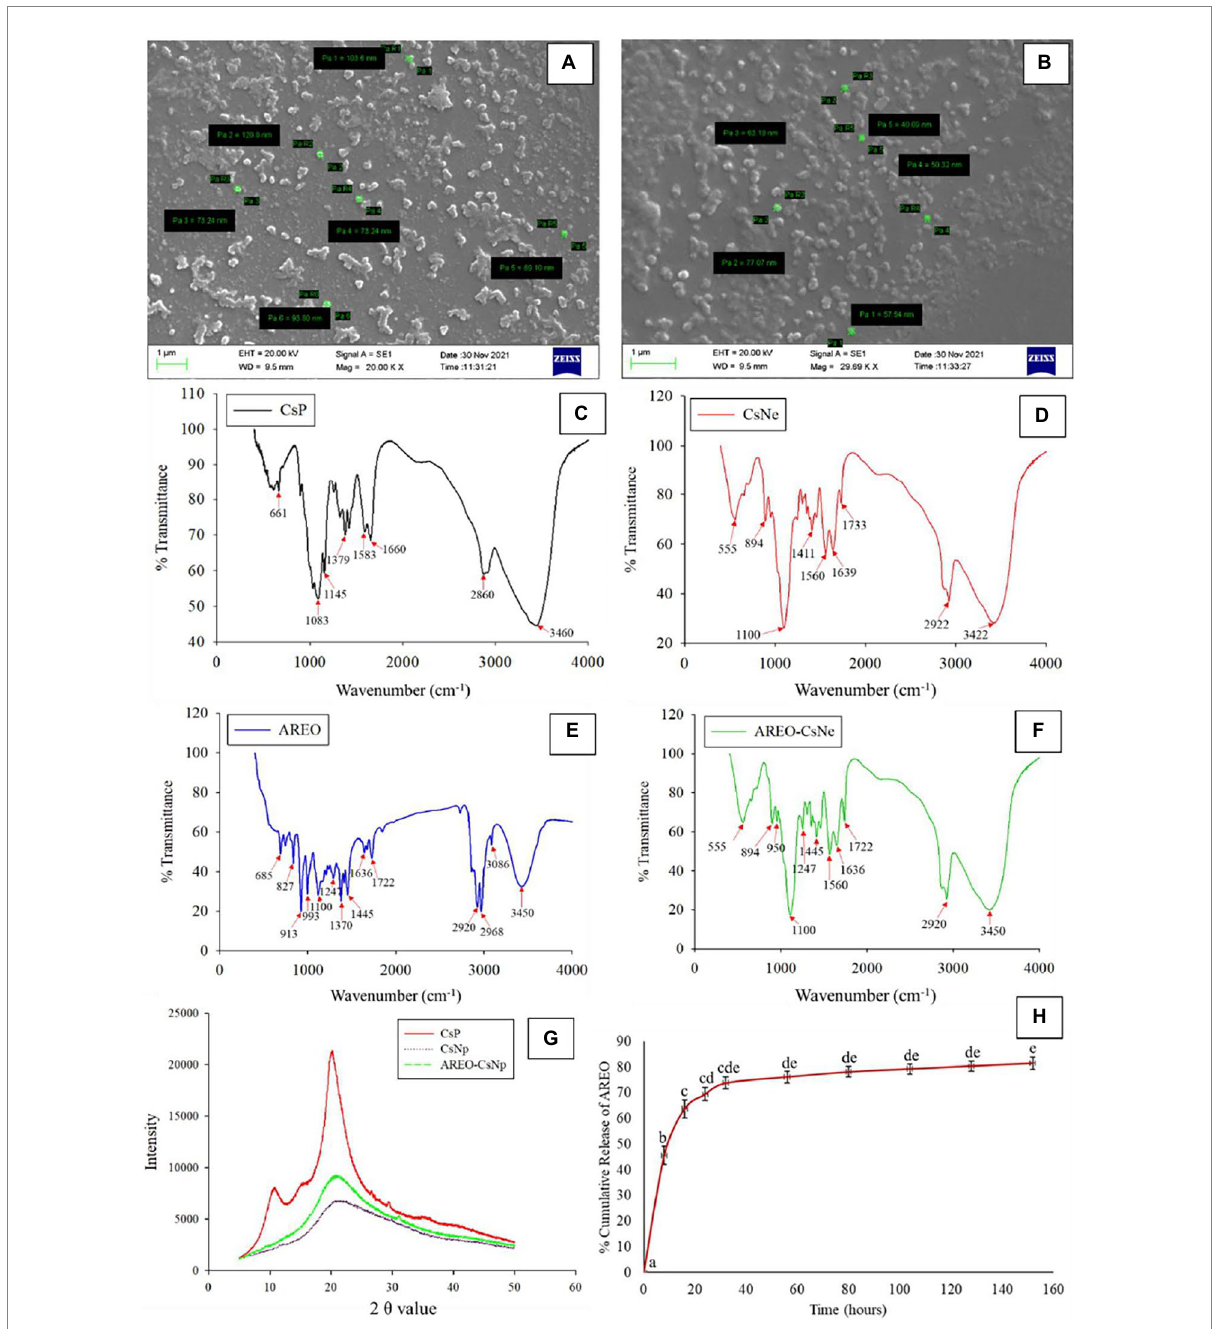
FIGURE 1 Scanning electron microscopic image of CsNe (A) Pa1 = 103.6, Pa2 = 120.8, Pa3 = 73.24, Pa4 = 73.24, Pa5 = 89.10, and Pa6 = 93.80 nm, respectively and AREO-CsNe (B) Pa1 = 57.54, Pa2 = 77.07, Pa3 = 63.18, Pa4 = 50.32, and Pa5 = 40.69 nm, respectively, FTIR spectra of CsP, CsNp, AREO, and AREO-CsNe (C–F) , X-ray diffraction patterns of CsP, CsNp, and AREO-CsNe (G) , and in-vitro release profile of AREOX-ray from AREO-CsNe nanoemulsion (H)